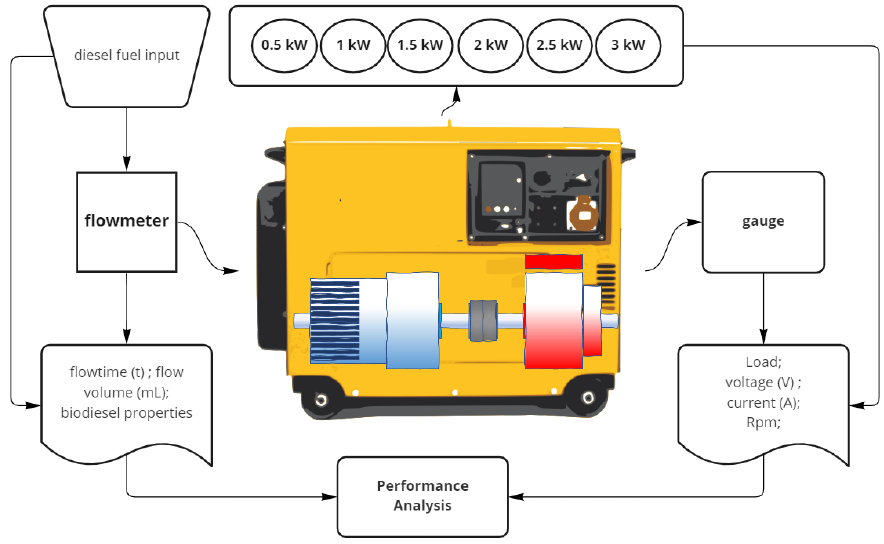
Figure 5. Schematic illustration of the experimental flow and data recording